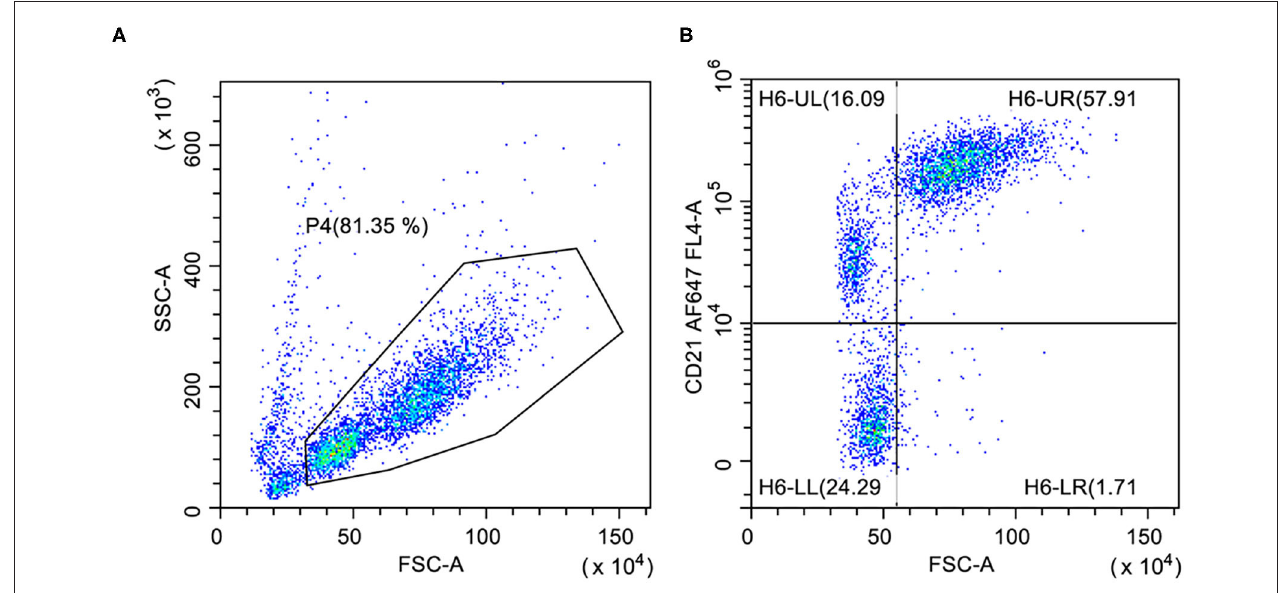
FIGURE 2 | Flow cytometric presentation of a large B-cell lymphoma. (A) Forward scatter (FSC) vs. side scatter (SSC) plot after doublet exclusion showing two populations of small- and large-sized cells. (B) FSC vs. CD21 plot of P4-gated cells showing higher CD21 expression on large cells (H6-UR) compared with small B-lymphocytes